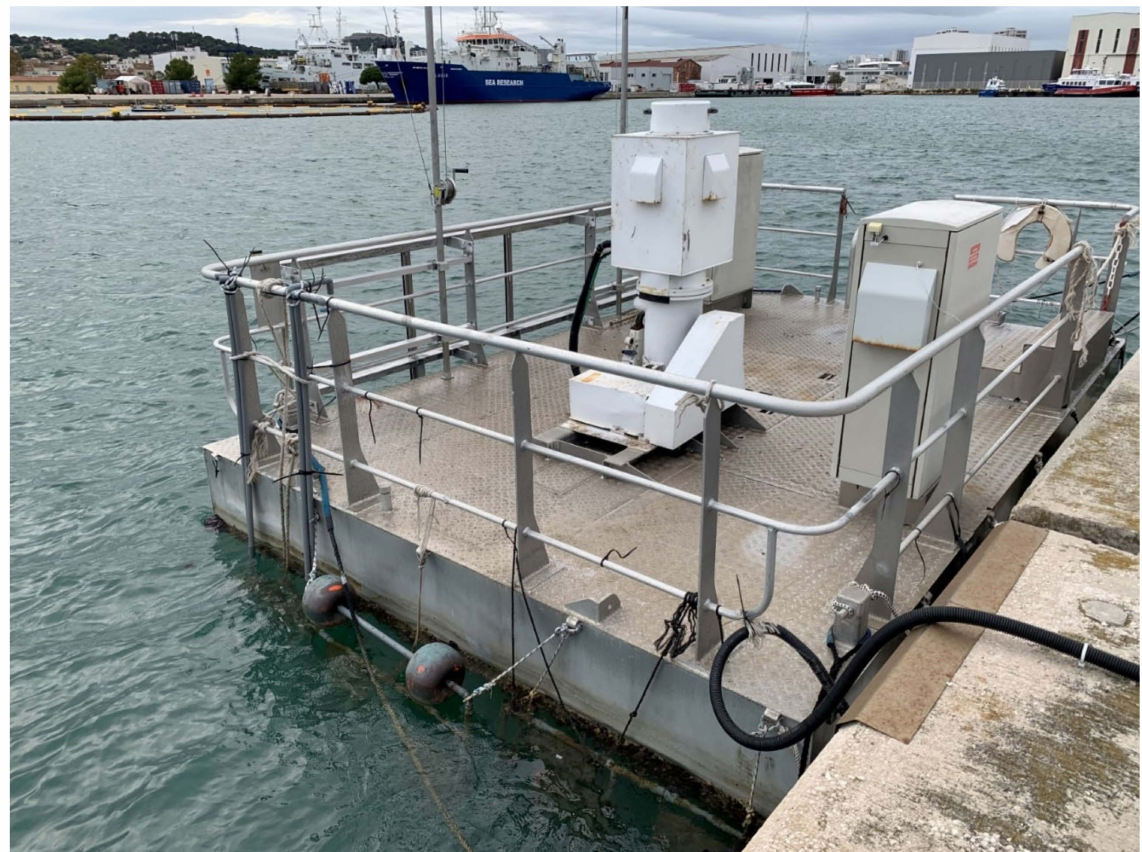
Figure 7. Floating